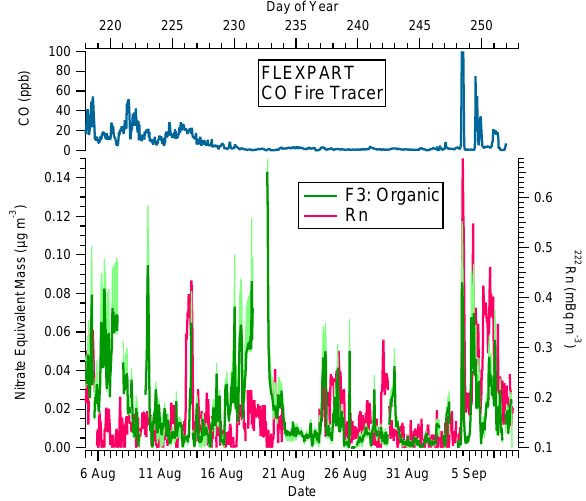
Fig. 10. Time series of the Organic Factor and 222 Rn (bottom panel) and the modelled biomass burning contribution of CO on the mea- surements (top panel).